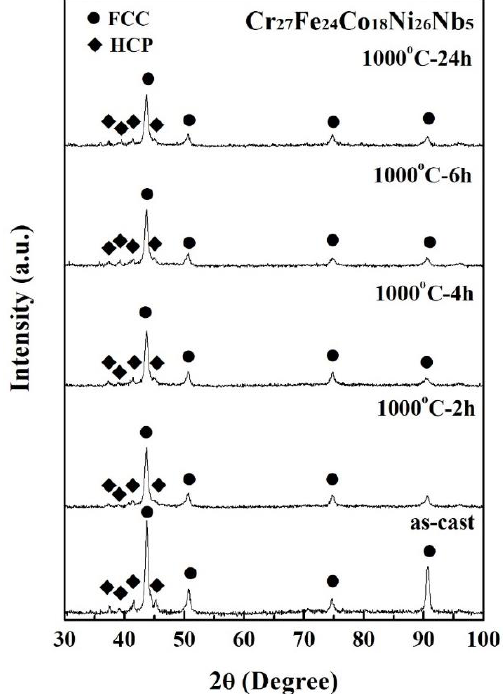
Figure 3. XRD patterns of Cr 27 Fe 24 Co 18 Ni 26 Nb 5 alloy in as-cast and as-annealed conditions.